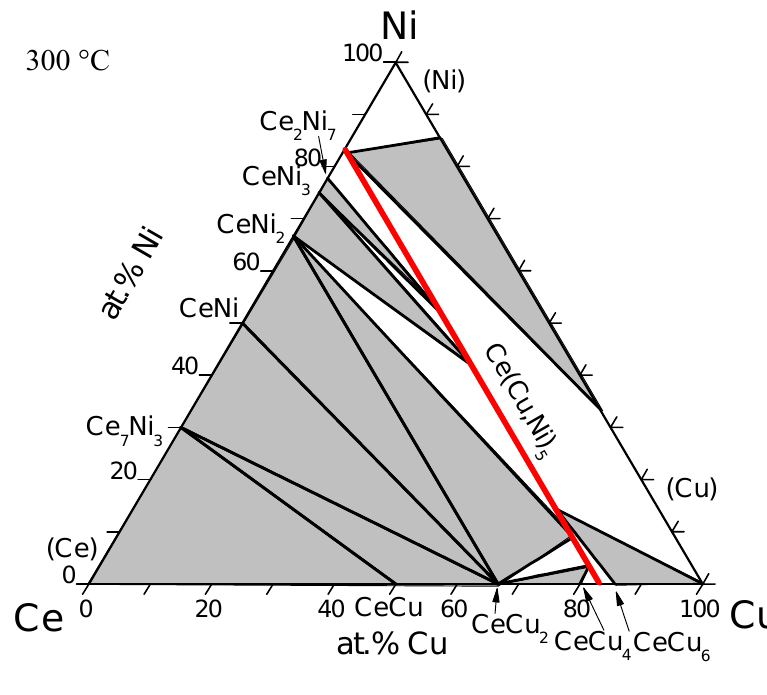
Figure 11. Calculated isothermal Ce-Cu-Ni section at 300 °C with one continuous solid